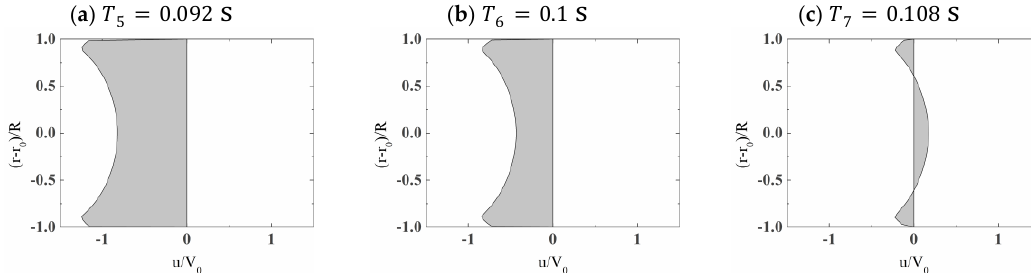
Figure 16. Axial velocity distribution at different time ( 𝑇 5 = 0.092 s , 𝑇 6 = 0.1 s , and 𝑇 7 = 0.108 s ) of the S1 monitoring point.